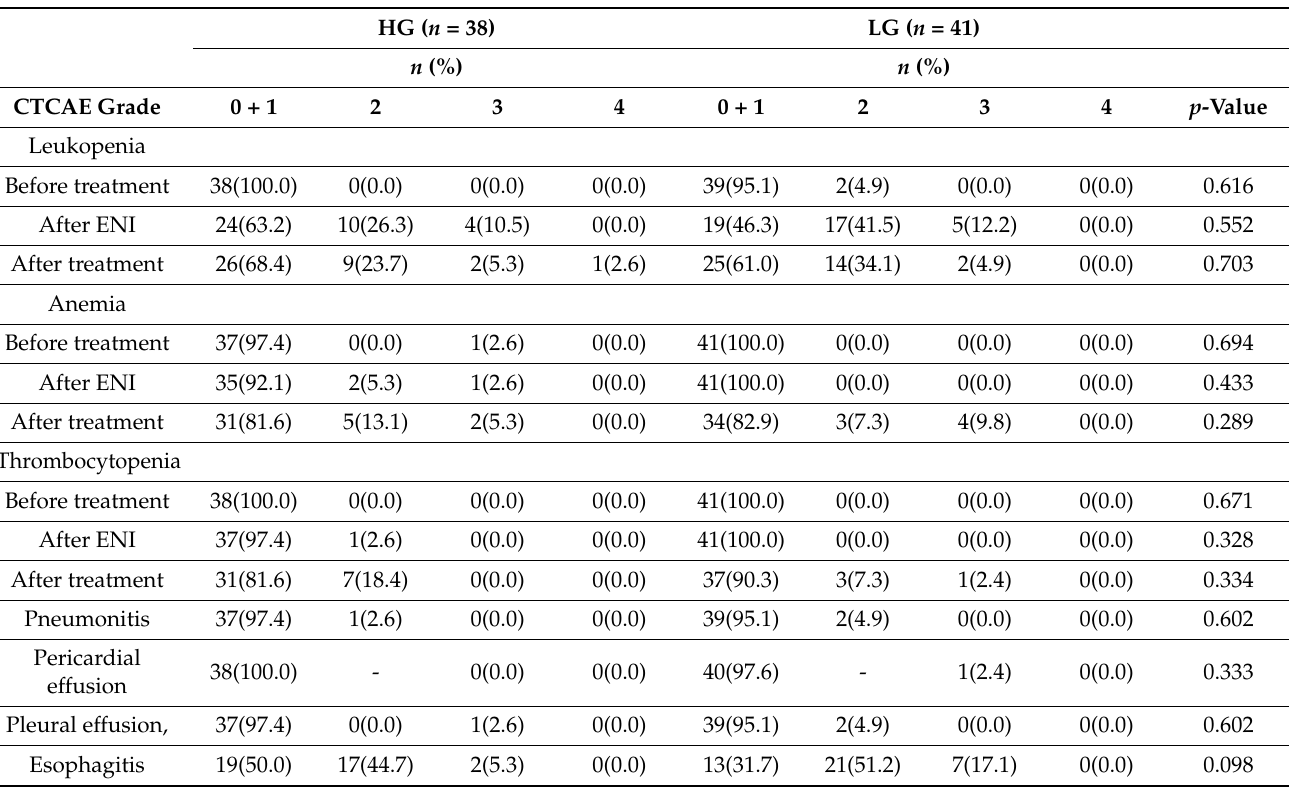
Table 4. Common Terminology Criteria for Adverse Events (CTCAE) Version5.0, grades for 79 pa-